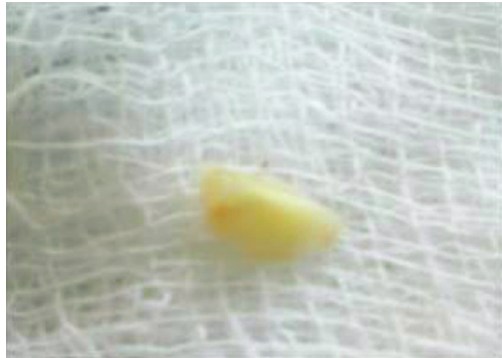
Figure 16: Fractured fragment of distofacial cusp of 26 after surface disinfection and application of bonding agent. Fragment demonstrates oblique nature of